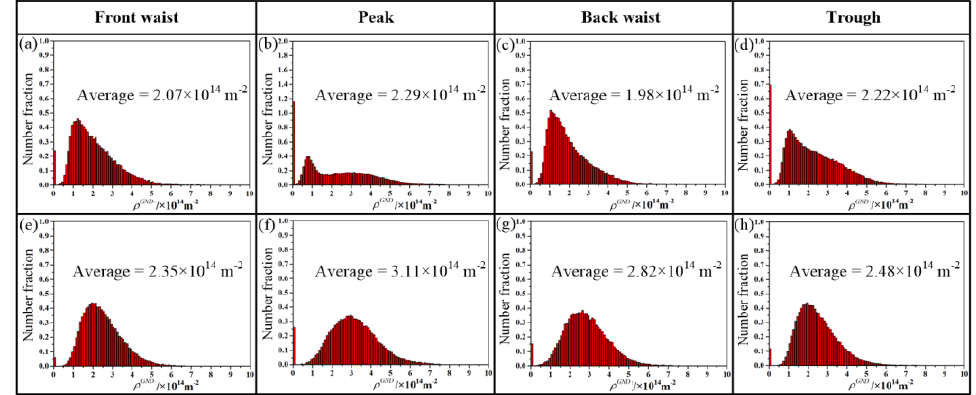
Figure 11. GND density distribution at four positions of the corrugated clad sheet: ( a – d ) Mg side; ( e – h ) Al side. ( e – h ) Al